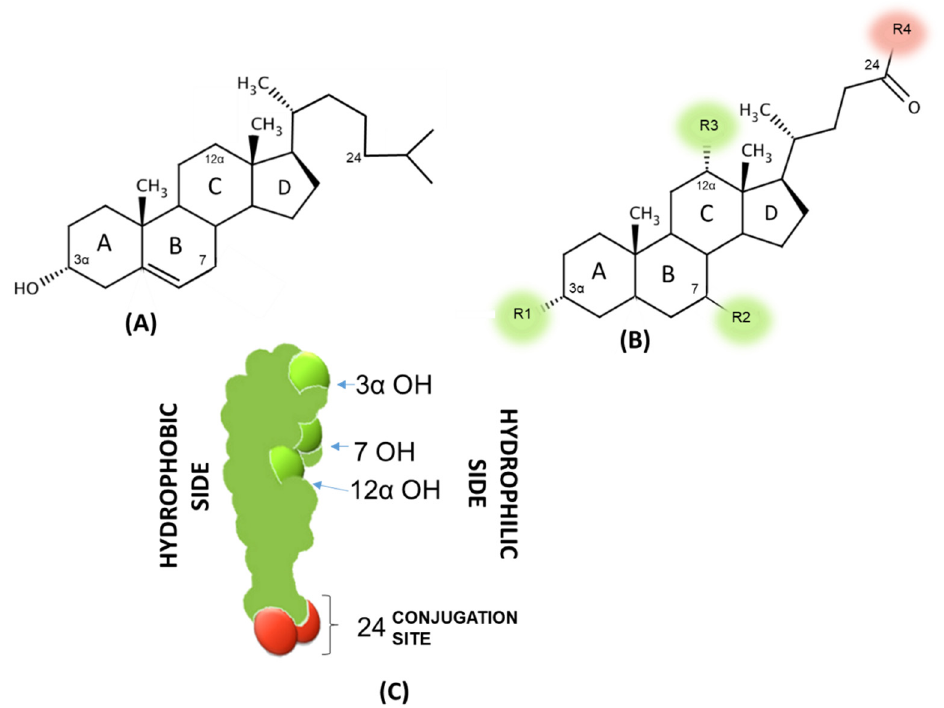
Figure 2. ( A , B ) General structures of cholesterol and bile acids. ( C ) Space-filling model of a BA. All three hydroxyl groups and the carboxyl group are faced to one side of the carbon skeleton to form a hydrophilic face, which is opposite to the hydrophobic face of the carbon skeleton.